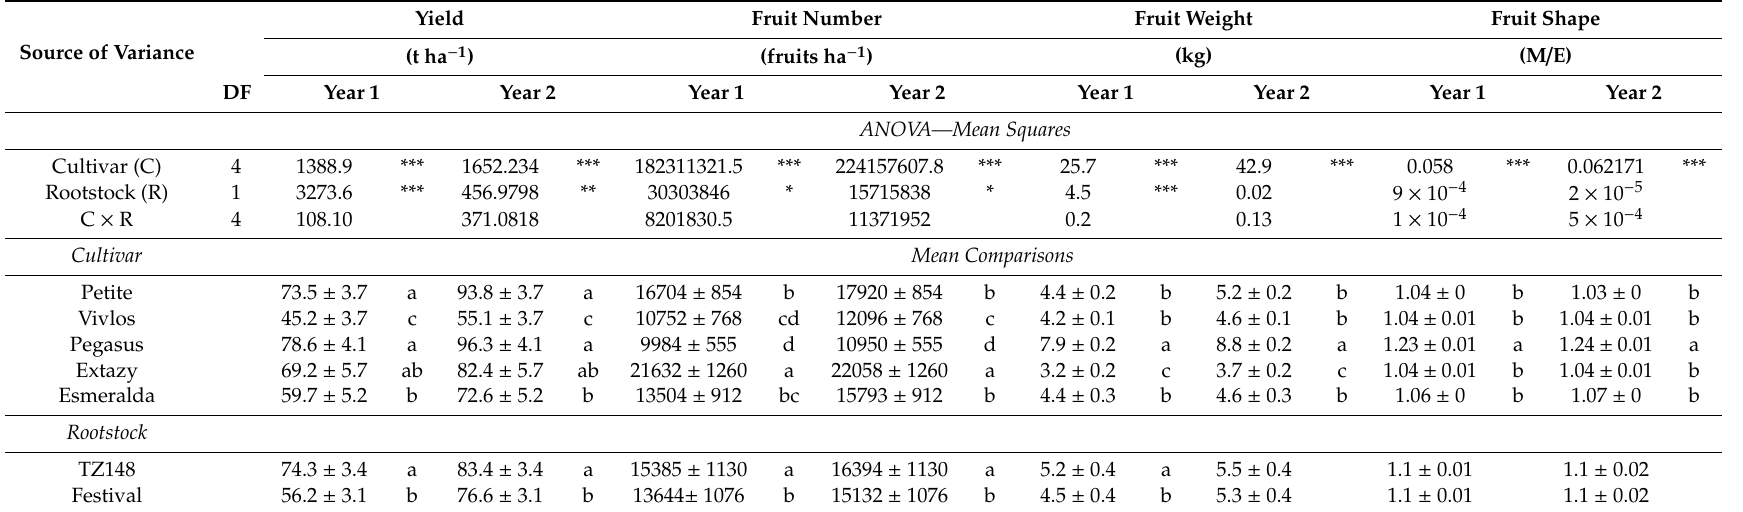
Table 1. Mean comparison for yield, fruit number, fruit mean weight, fruit shape (meridian / equatorial diameter), at harvest of watermelon fruit from cvs. Petite, Vivlos, Pegasus, Extazy and Esmeralda grafted on two rootstocks types. Values represent means ± SE.